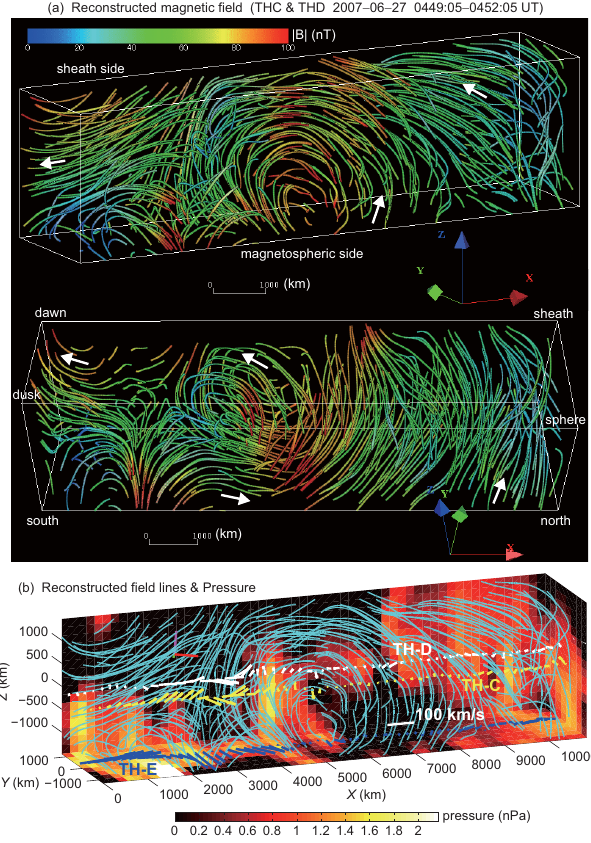
Figure 2. Three-dimensional (3-D) structures of the magnetic field and pressure recovered from the THC and THD data. (a) 3- D representations of the reconstructed field lines, with the field intensity in colour. The top view is roughly from the south- dusk, while the bottom view is from the duskside magnetosheath. The three GSM components of the reconstruction axes are: X = ( 0 . 1024 , − 0 . 3883 , 0.9158), Y = ( 0 . 0780 , − 0 . 9147 , − 0.3966), and Z = ( 0 . 9917 , 0 . 1120 , − 0 . 0634). The white arrows represent the ap- proximate orientation of the magnetic field in the surrounding re- gions. Please refer to the supplement for a movie of the 3-D recon- structed field, showing the field configuration viewed from various angles. (b) The 3-D field lines (cyan lines) and plasma pressure at the three boundaries of the reconstruction domain in colour. The white, yellow, and blue arrows have roots on the paths of THD, THC, and THE, respectively, and show the ion velocity vectors measured by those probes and transformed into the deHoffmann– Teller (HT) frame. The magenta, green, and red bars at the upper left represent the GSM x,y, and z axes,